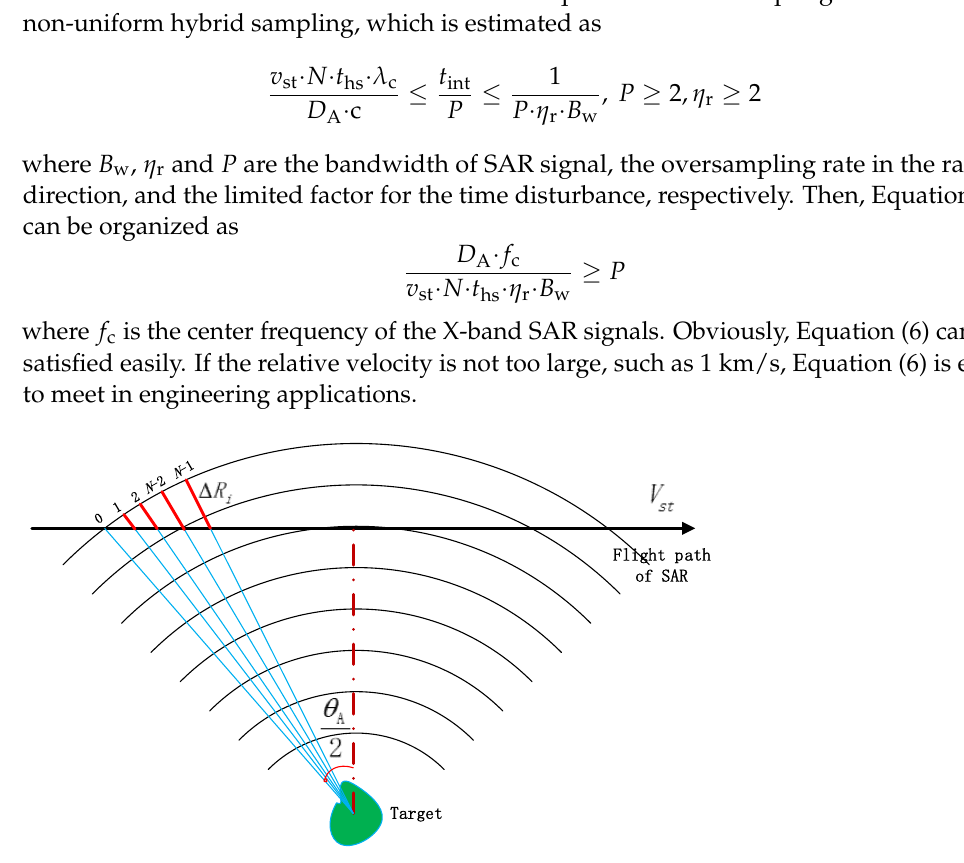
Figure 4. Analysis of the non-uniform hybrid sampling technology for the mini-SAR.